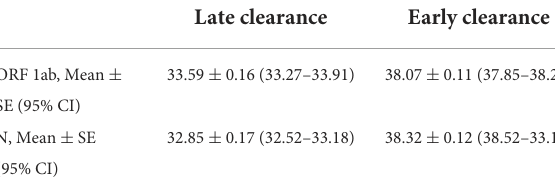
TABLE 6 Mean Ct values for RT-PCR on ORF 1ab gene and N gene during viral RNA